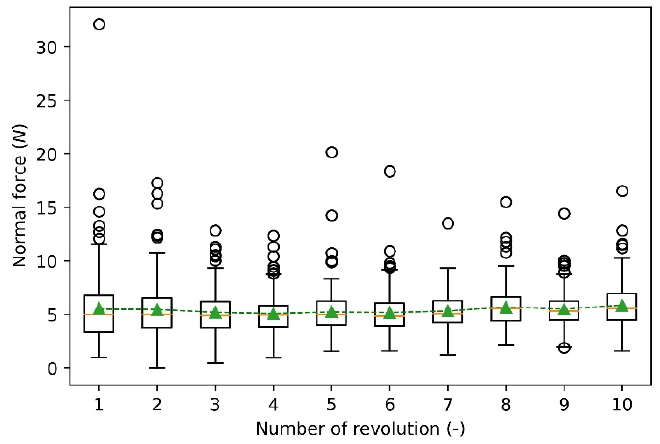
Figure 9. Normal force of ten revolutions.